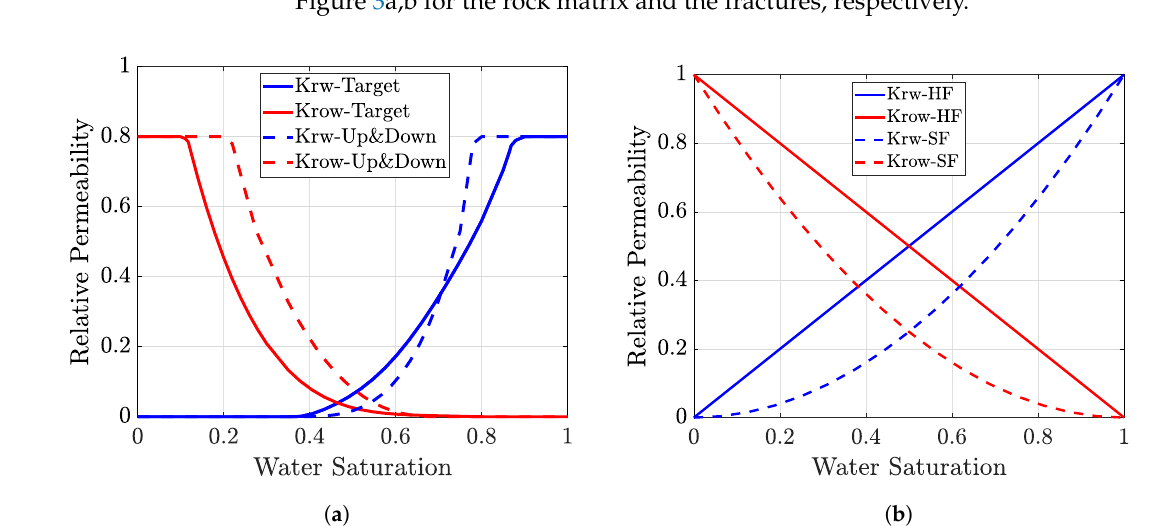
Figure 3. Water-Oil relative permeability curves. ( a ) Rock matrix relative permeability curves: solid curves represent the target zone and dashed curves the upper and lower zone (Up& D own). ( b ) Fracture relative permeability curves: solid curves represent the hydraulic fractures (HF), and dashed curves represent secondary fractures